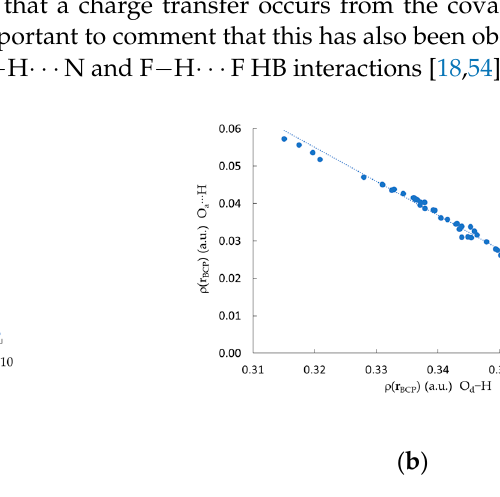
Figure 4. ( a ) Relationship between d OH distance () and ρ ( r BCP ) (a.u.). The fitted curve corresponds to ρ ( r BCP ) = 5.380 e − 2.810 d OH , r 2 = 0.9996, d OH makes reference to the distances between either O d H or O a H; ( b ) Relationship between ρ ( r BCP ) at Od–H and ρ ( r BCP ) at O a · · ·